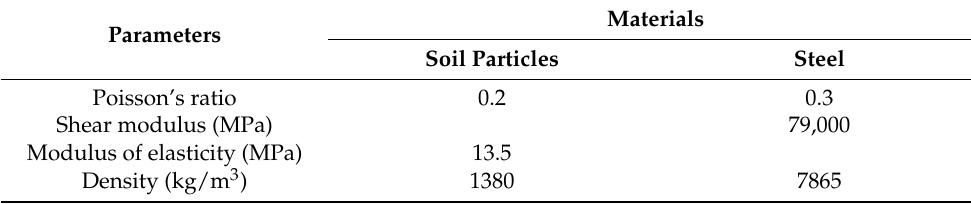
Table 4. Parameters of discrete element